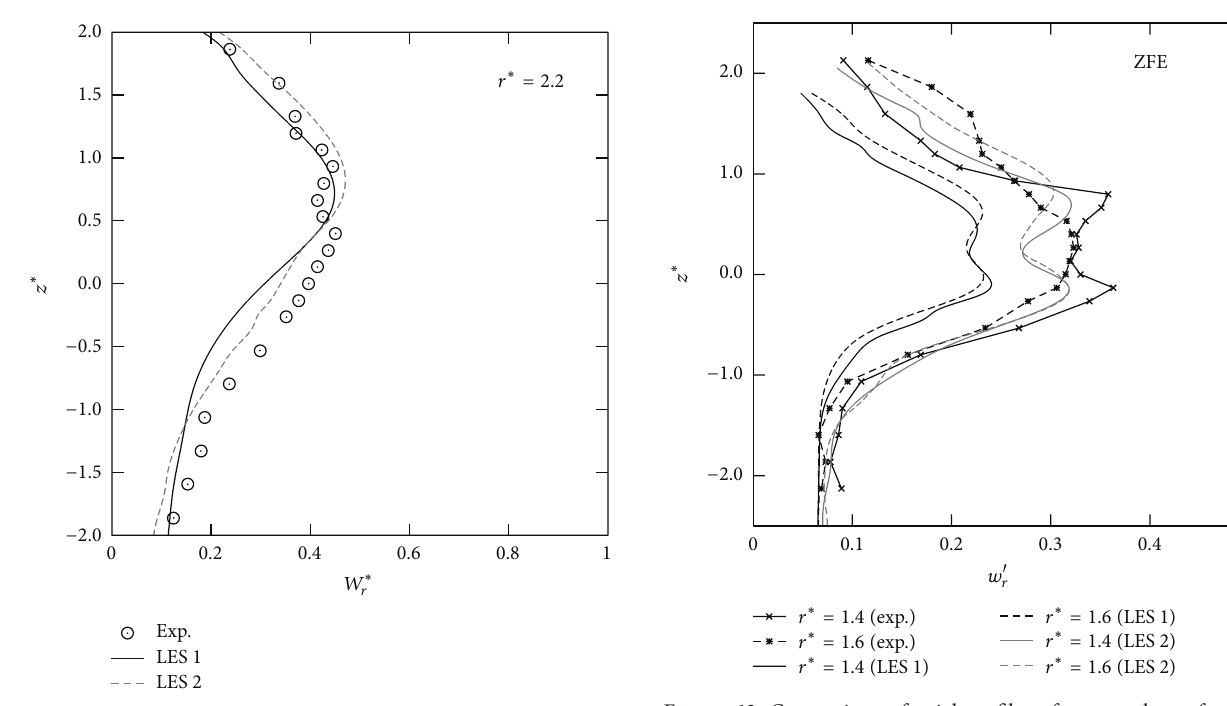
Figure 12: Comparison of axial profiles of r.m.s. values of radial fluctuation velocity in the zone of establishment (ZFE).